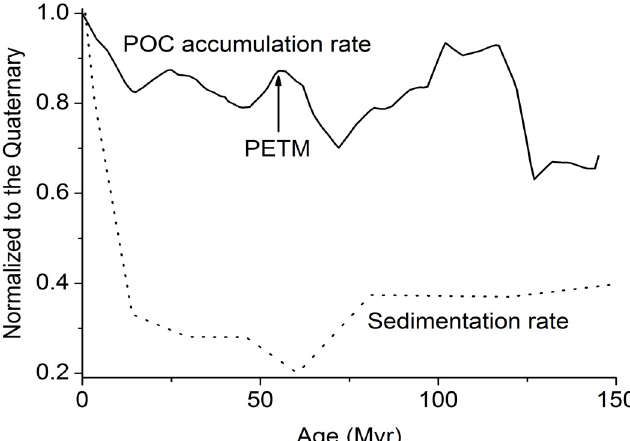
Figure 4. Accumulation of POC and terrigenous sediments over the last 150 Myr. The solid line shows the global marine POC accumulation rate normalized to the Quaternary value while the dotted line gives the global rate of terrigenous sedimentation at the seafloor normalized to the Quaternary [17]. The Paleocene-Eocene Thermal Maximum (PETM, at 55.5 Myr) is indicated by the vertical